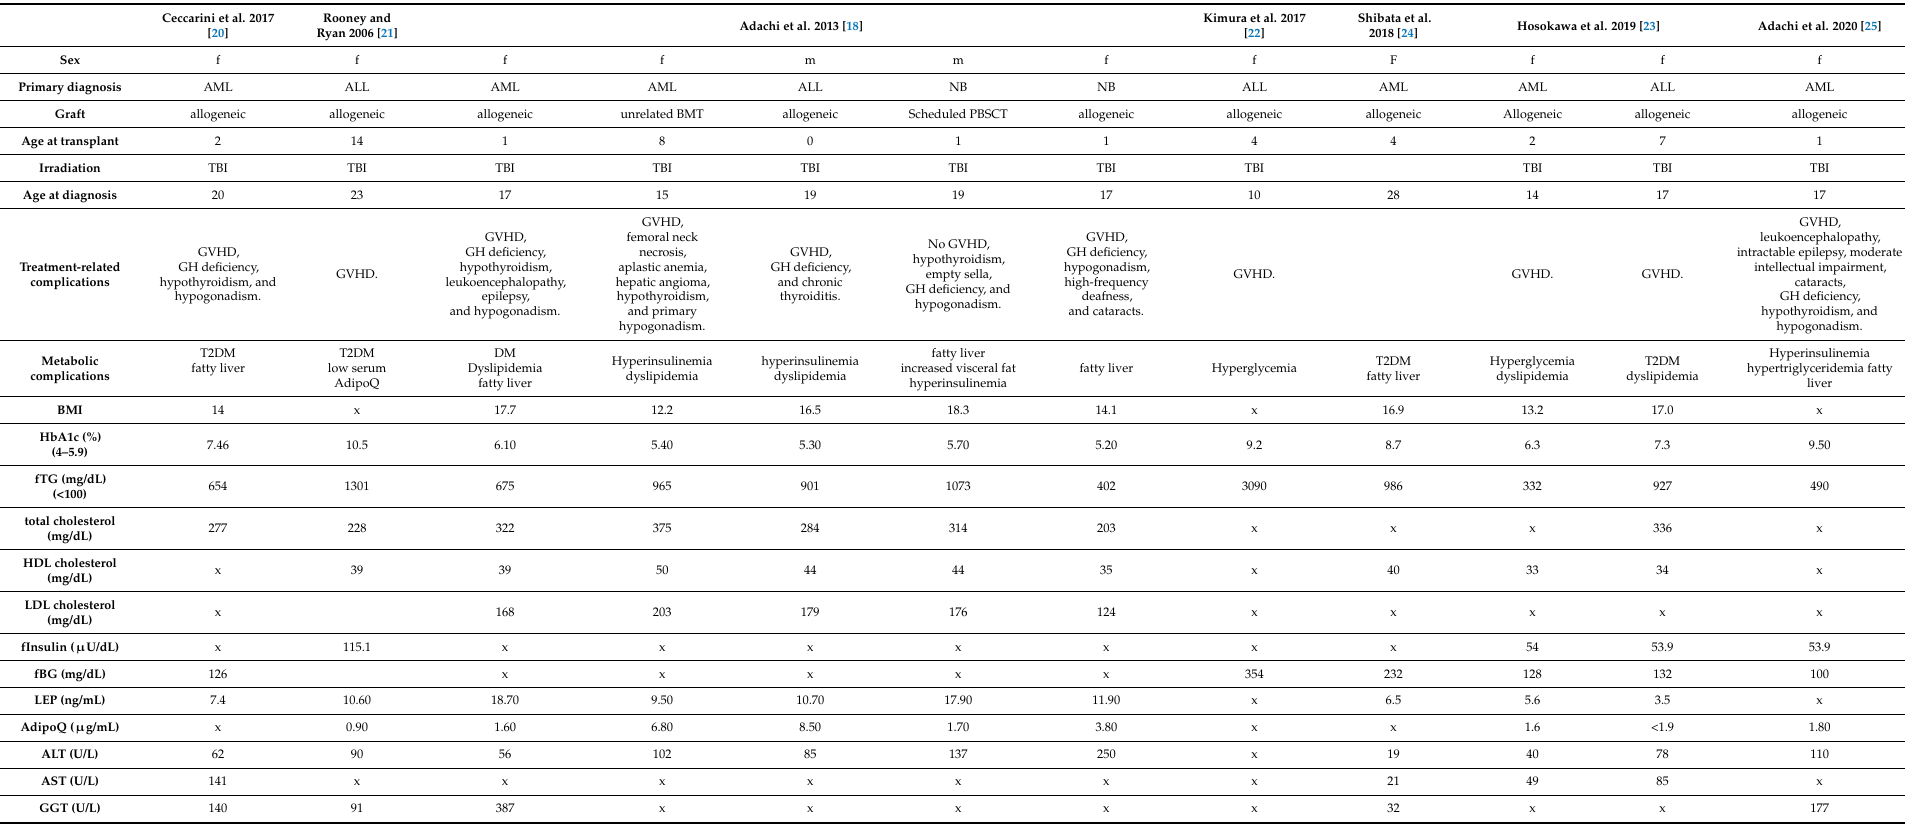
Table 1. Clinical characteristics of patients with lipodystrophies (LD) upon hematopoietic stem cell (HSC)